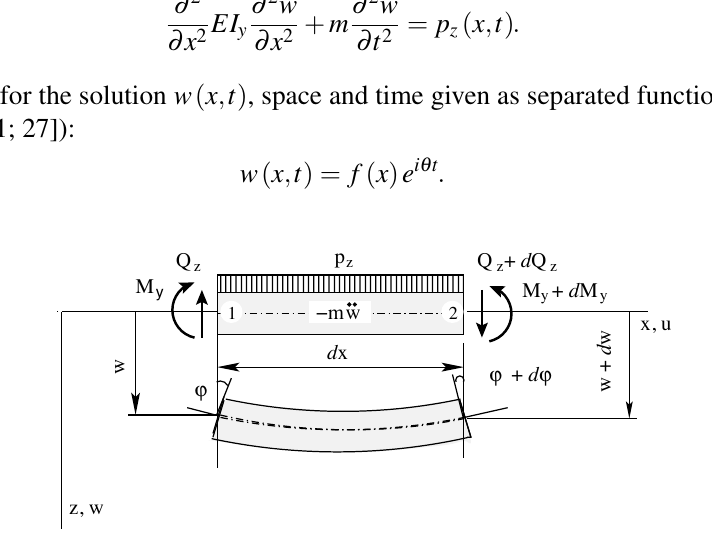
Fig. 1. Inertial force acting on a differential beam element.